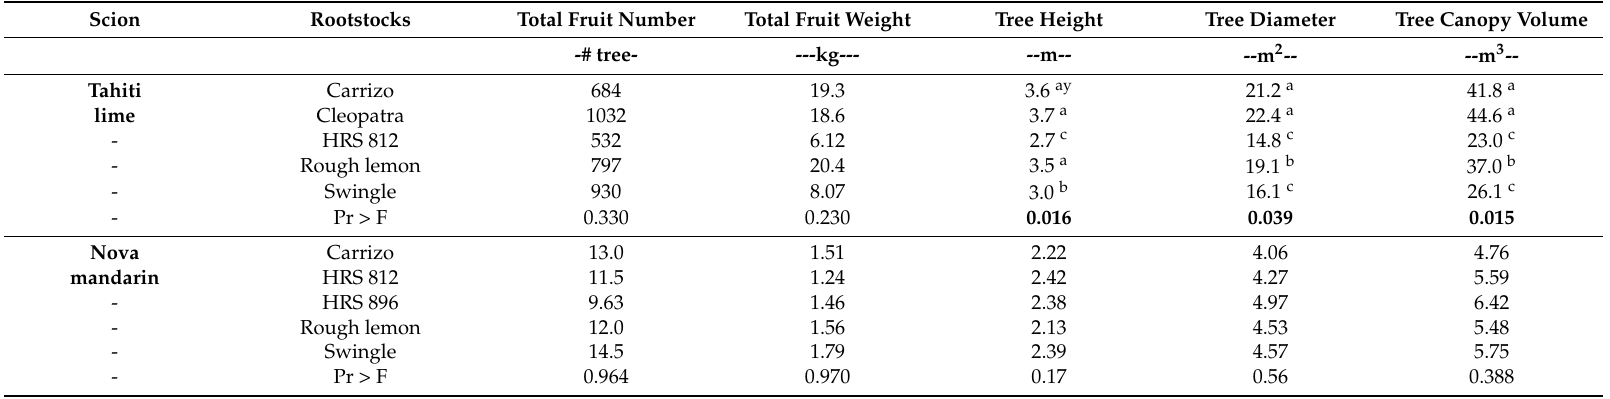
Table 3. Tree variables and fruit production of two citrus varieties grafted to five different rootstocks planted at the Agricultural Experiment Substation of